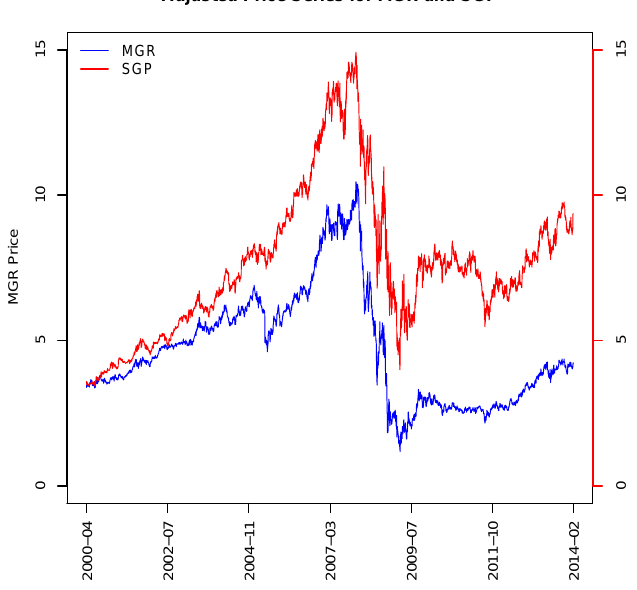
Figure 5. Time series plots of near-linear correlated stocks identified in a scatter plot of components 151 and 152: Mirvac Group (MGR) and Stockland Corporation Limited (SGP)—two stocks in the real estate sector.